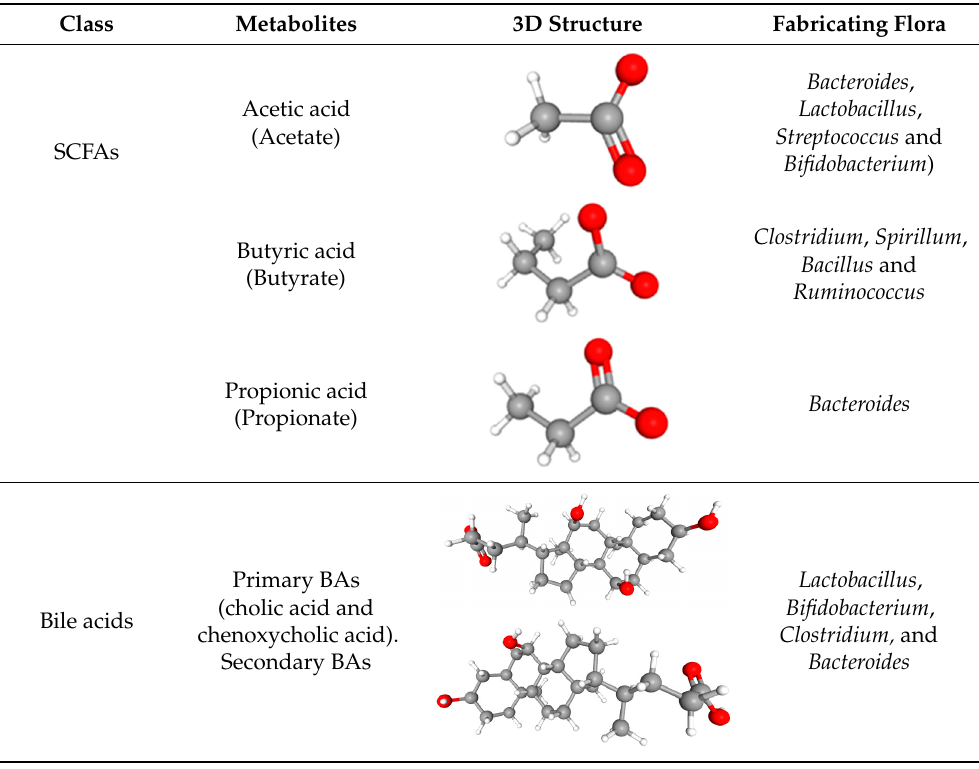
Table 1. Human gut microbiota produces SCFAs and bile acid metabolites.